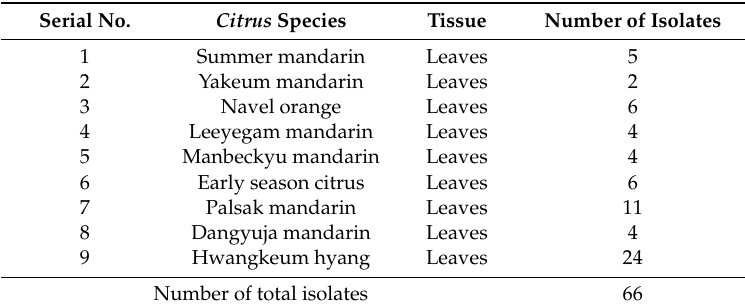
Table 1. List of endophytic bacteria isolated from Citrus spp.